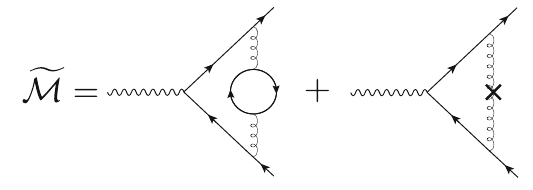
Fig. 7 Diagrams entering in the UV renormalisation of scattering pro- cess γ ∗ → b ¯ b